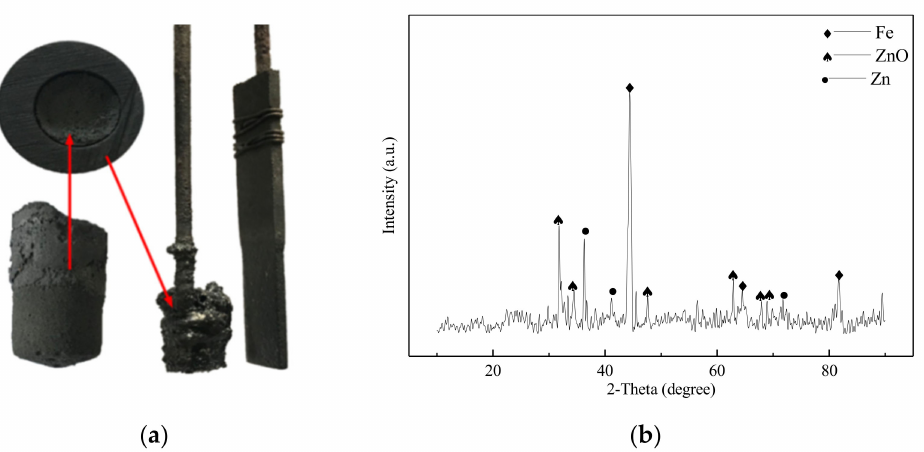
Figure 11. ( a ) Experimental physical diagram and ( b ) XRD analysis diagram ( E = 1.8 V, T = 800 ◦ C, t = 8